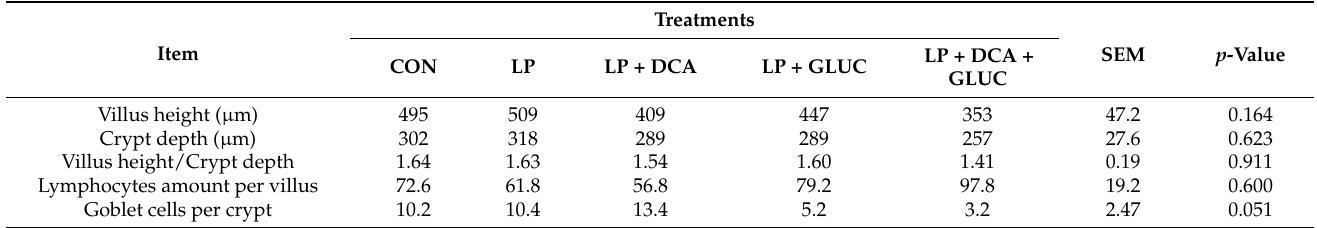
Table 4. Effects of supplementing low protein (LP) diets with sodium dichloroacetate (DCA) and glucose (GLUC) on the ileum histology of growing-finishing